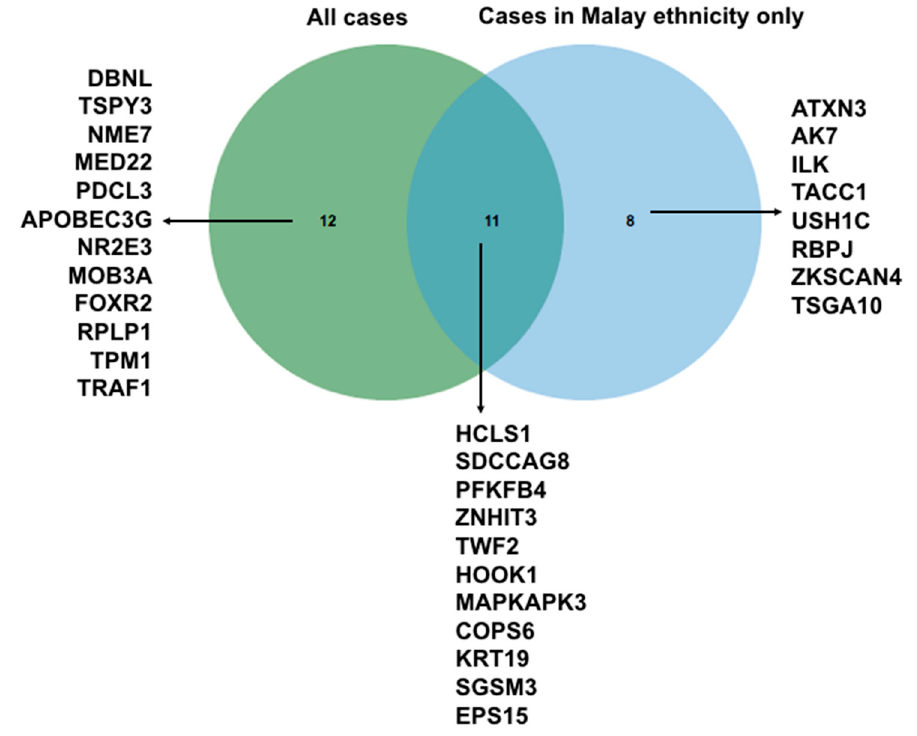
Figure 9. Venn diagram showed that there is a unique cluster of biomarkers of cases across two ethnicities of tested sample.